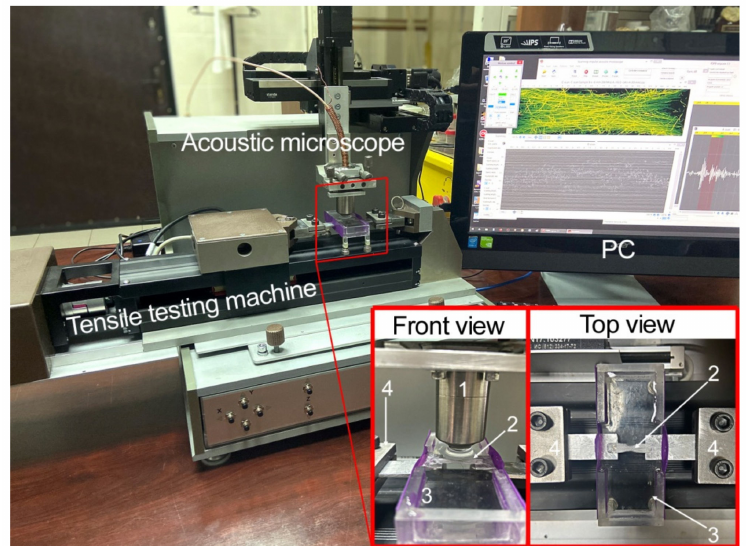
Figure 1. Experimental setup—acoustic microscope combined with horizontal testing machine. The microscope and the tensile machine were controlled form one PC. The specimen (2) was glued to the metallic holders that were placed into the clamps (4) and passed through the elastic side of the water tank (3). The acoustic lens (1) was immersed in water and positioned above the specimen surface, while its focus was localized in the volume of the